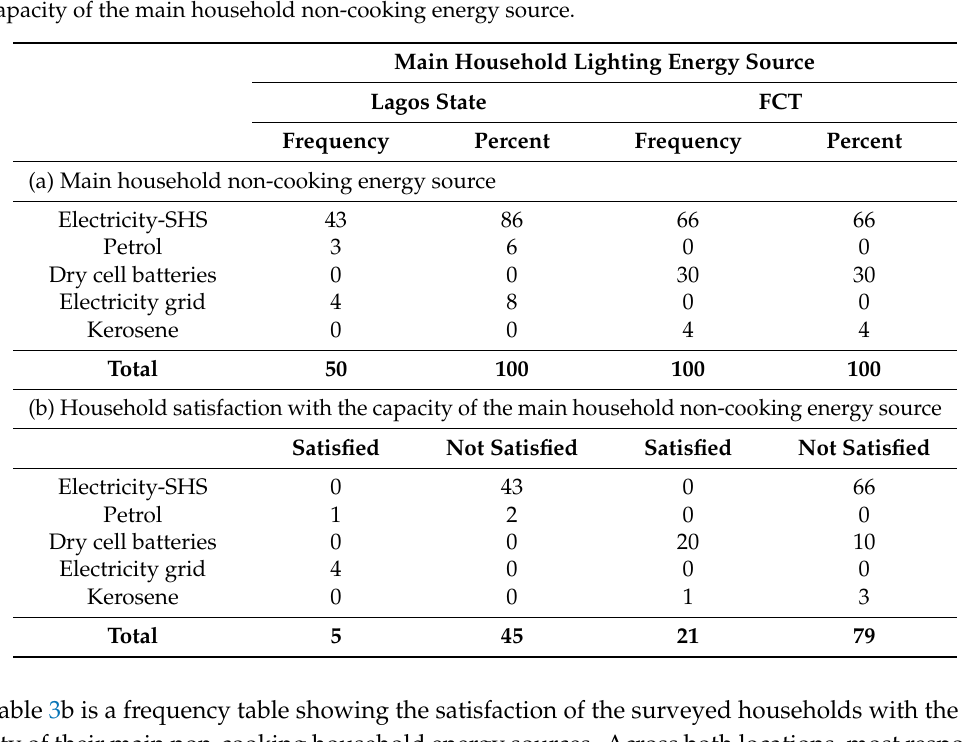
Table 3. Main energy source for non-cooking (mostly lighting) purposes and satisfaction with the capacity of the main household non-cooking energy source.